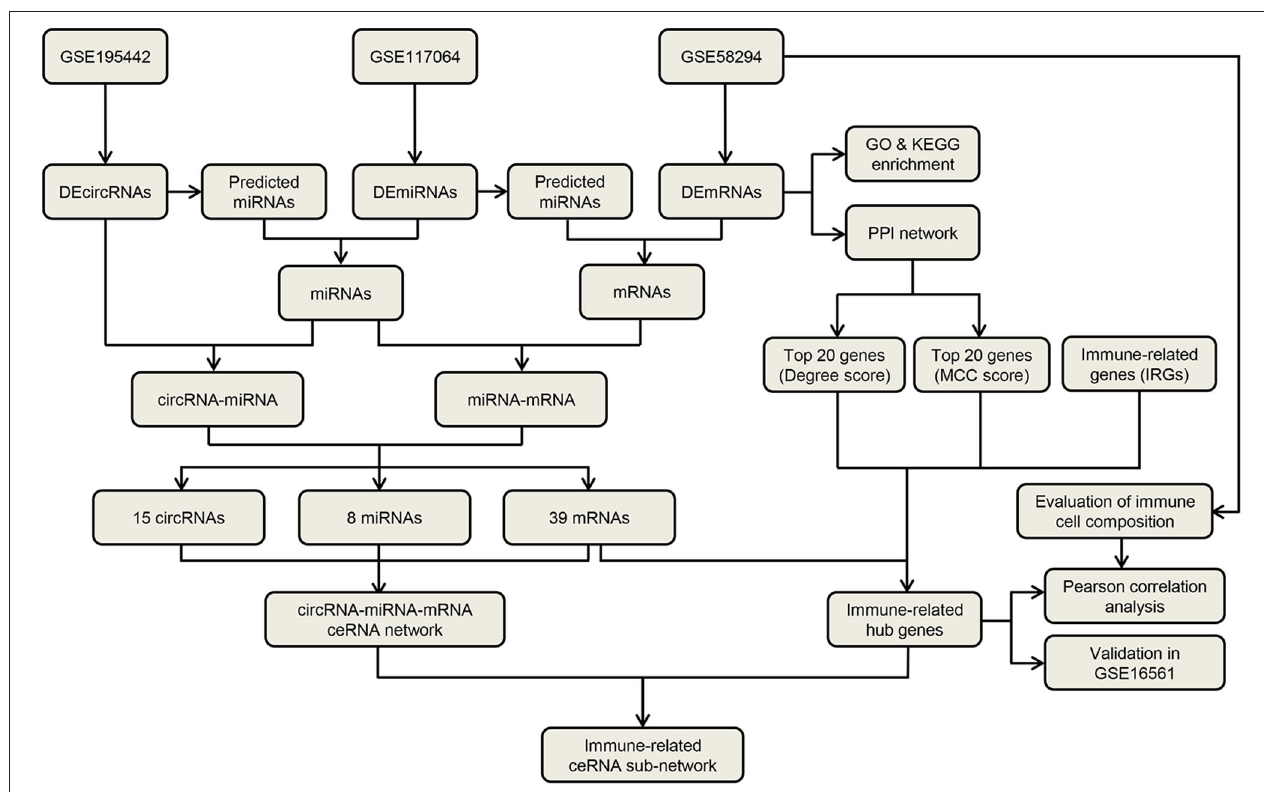
FIGURE 1 | The flow diagram for the whole study.